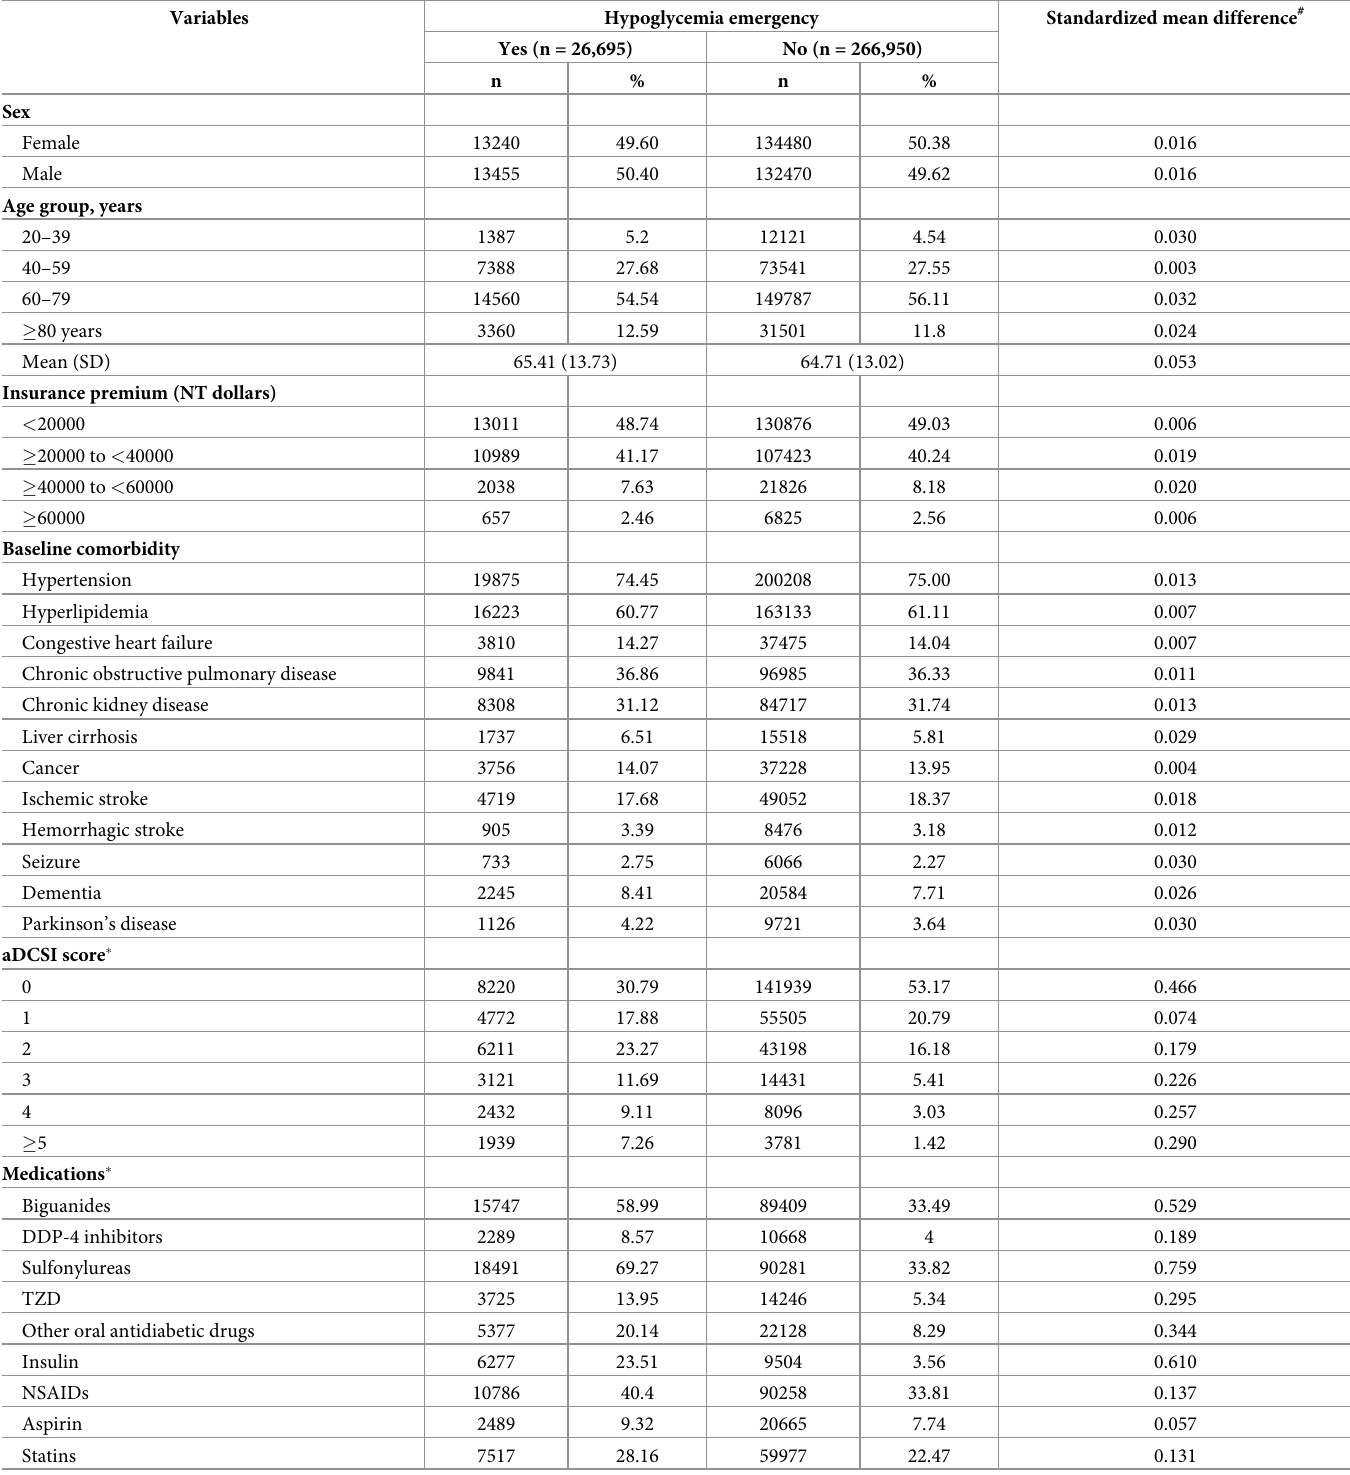
Table 1. Demographic and clinical characteristics in patients with type 2 diabetes with and without hypoglycemic emergency after propensity